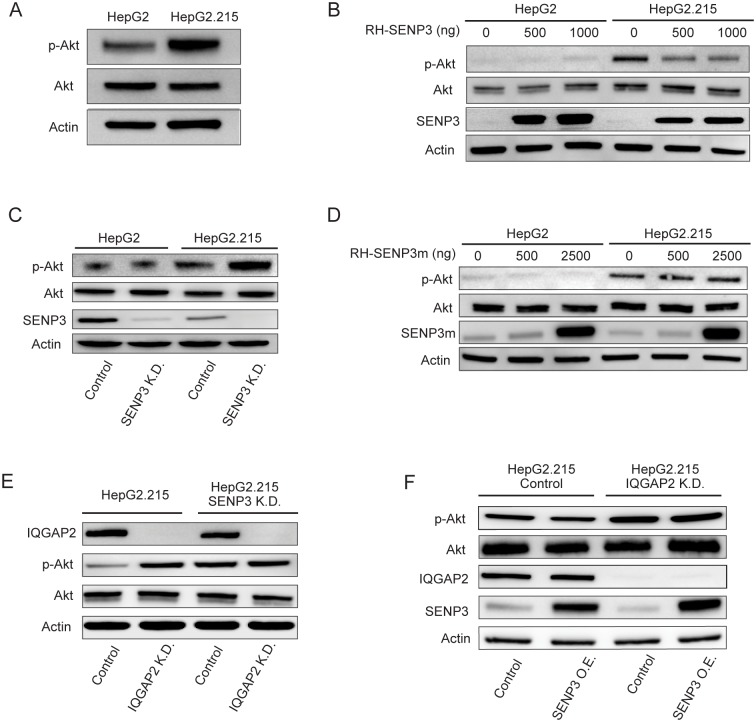
The SENP3-IQGAP2 axis mediates Akt phosphorylation in HBV infected cells.(A-F) Comparison of AKT phosphorylation by immunoblotting in HepG2 and HepG2.215 cells (A), in HepG2 and HepG2.215 cells both with ectopic expression of SENP3 by transient transfection of differing amounts of RH-tagged SENP3 constructs (B), in HepG2-SENP3 K.D. and HepG2.215-SENP3 K.D. cells compared with corresponding control cells (C), in HepG2 and HepG2.215 cells with ectopic expression of SENP3 mutant (C532A) (SENP3m) by transient transfection of differing amounts of RH-tagged SENP3m constructs (D), in HepG2.215 cells with IQGAP2 K.D., SENP3 K.D., and knockdown of both proteins (E), in HepG2.215-control and HepG2.215-IQGAP2 K.D. with and without ectopic expression of SENP3 by transient transfection of RH-tagged SENP3 constructs (F).